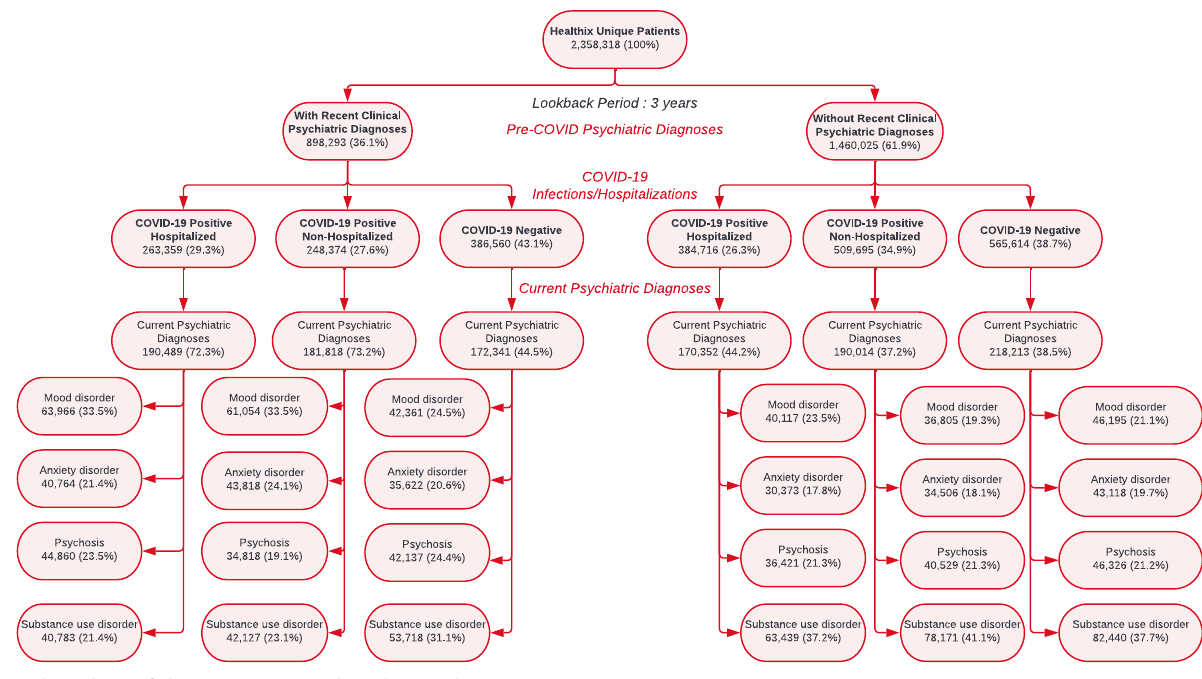
Fig. 1 Flow chart of data extraction and study